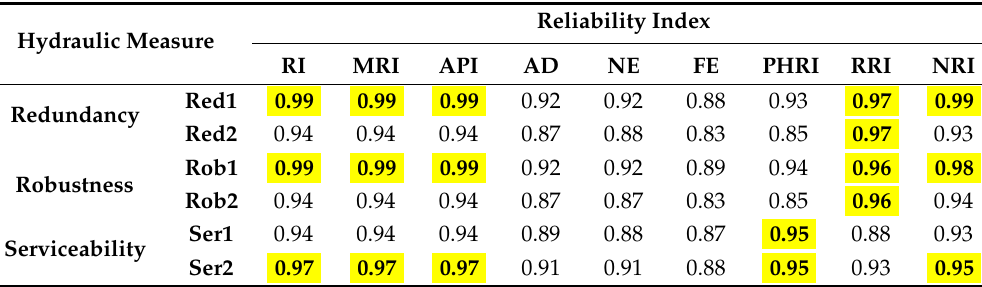
Figure 5. Scatter plots of Scenario 2 ( x -axis—Reliability index; y -axis—Hydraulic measures). The plots highlighted in yellow show high correlation coe ffi cient of 0.95 or higher. Table 5. Correlation coe ffi cients for Scenario